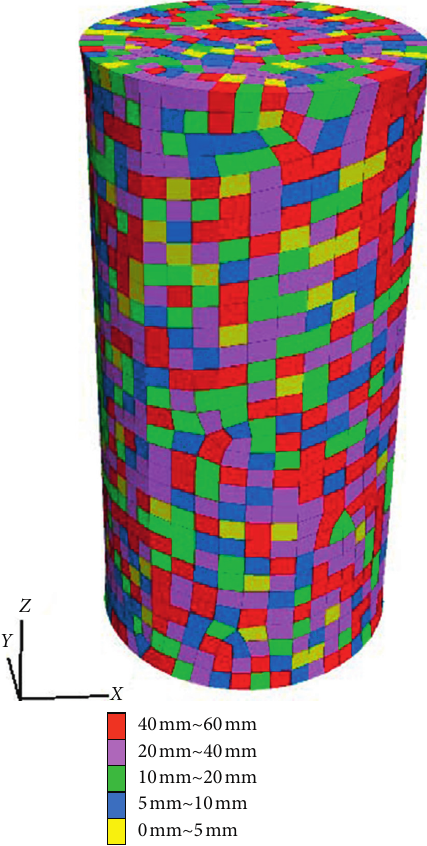
Figure 8: A schematic diagram of a triaxial numerical